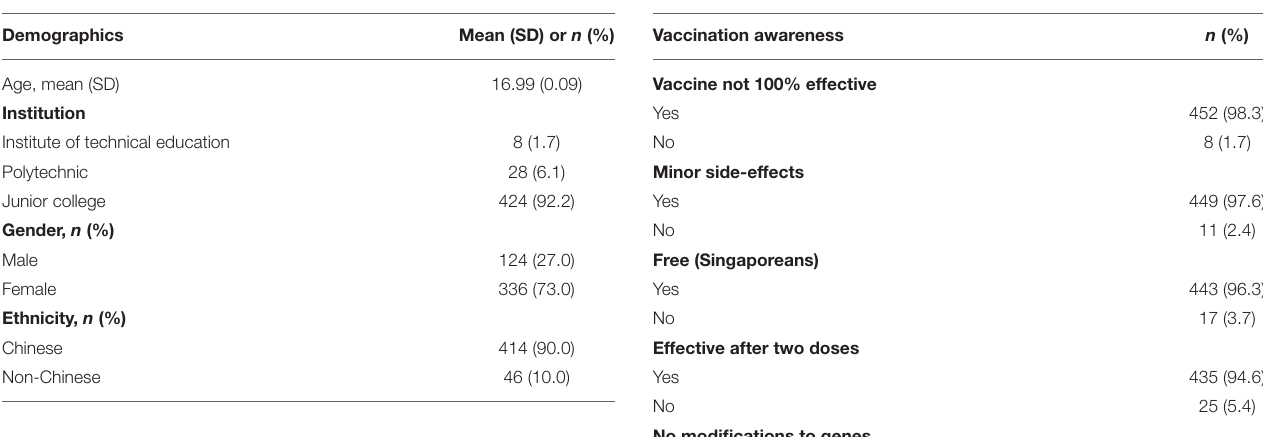
TABLE 1 | Subject demographics ( n = 460). TABLE 2 | COVID-19 vaccination awareness ( n =